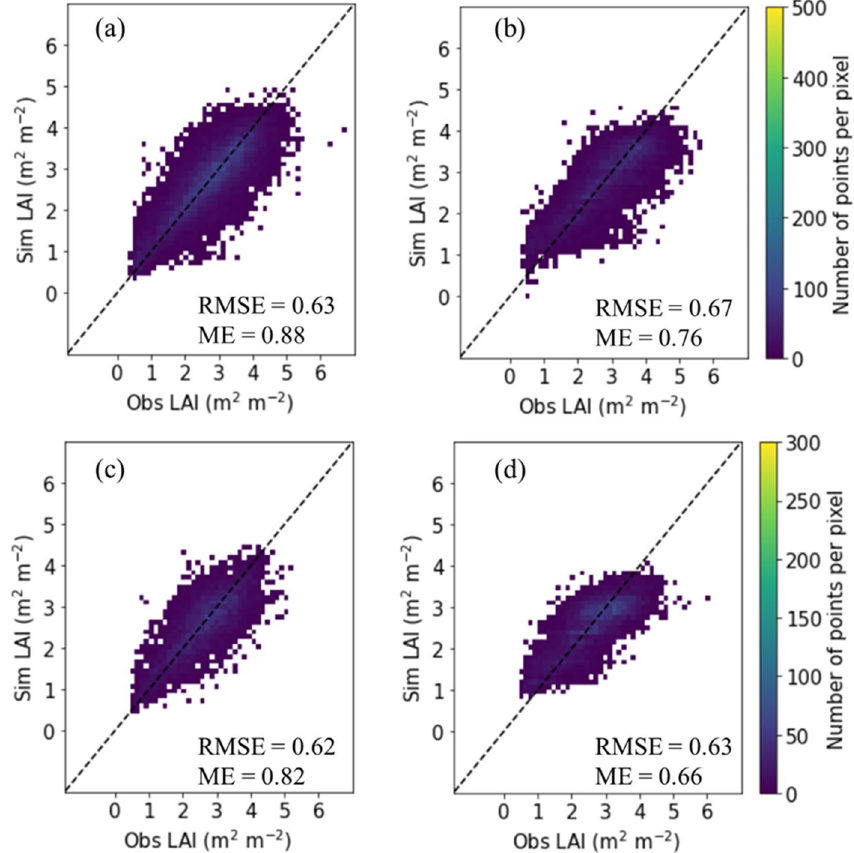
Figure 1. Simulated (Sim) versus observed (Obs) leaf area index (LAI) of paddy rice using the ( a and c ) random forest (RF) regressor and ( b and d ) deep neural network (DNN) regressor in (and b ) Cheorwon (n = 10,388) and ( c and d ) Paju (6,622), South Korea. RMSE and ME stand for root mean square error and model